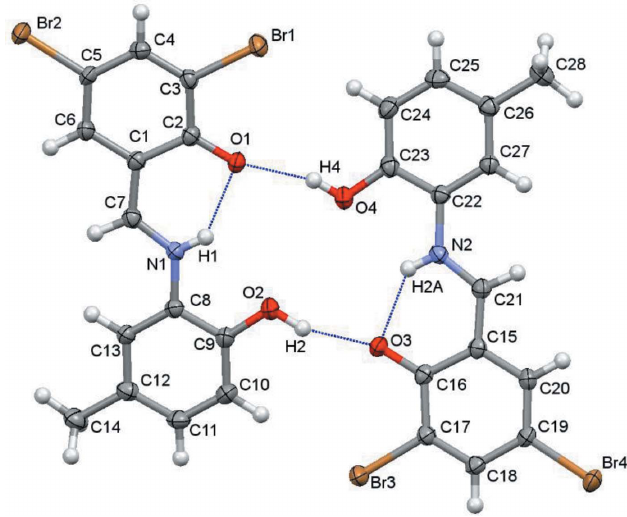
Figure 1 The asymmetric unit of the title compound, showing the atom-numbering scheme. Displacement ellipsoids are drawn at the 50% probability level and H atoms are shown as spheres of arbitrary radii. Intramolecular N— H (cid:3)(cid:3)(cid:3) O and intermolecular O—H (cid:3)(cid:3)(cid:3) O hydrogen bonds are indicated by dashed